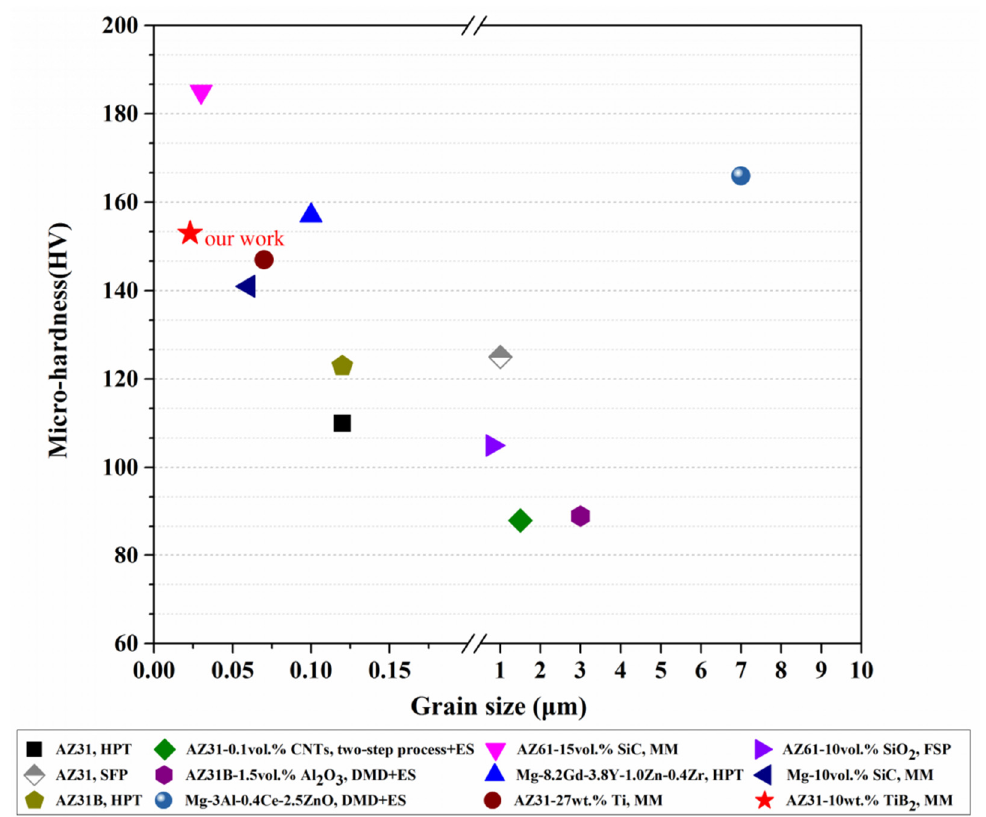
Figure 11. Comparison of the micro-hardness and grain sizes of various Mg alloys [25,38–47].